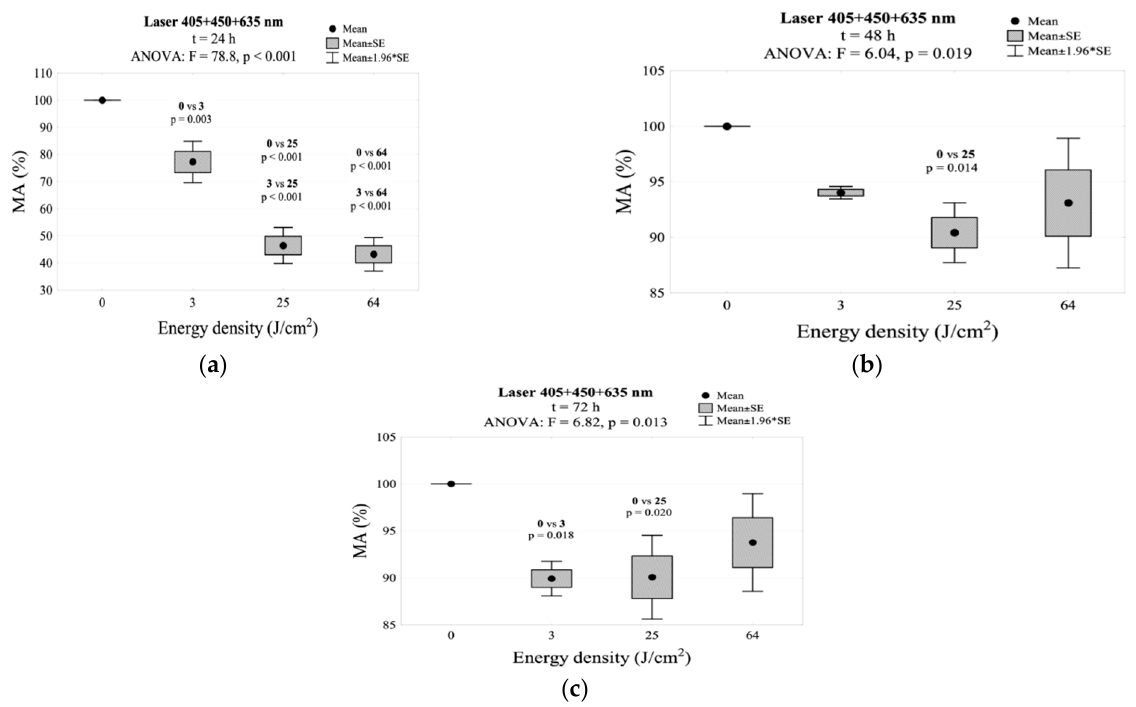
Figure 7. MA values measured: ( a ) 24 h, ( b ) 48 h, ( c ) 72 h after irradiation using the 405 + 450 + 635 nm laser.